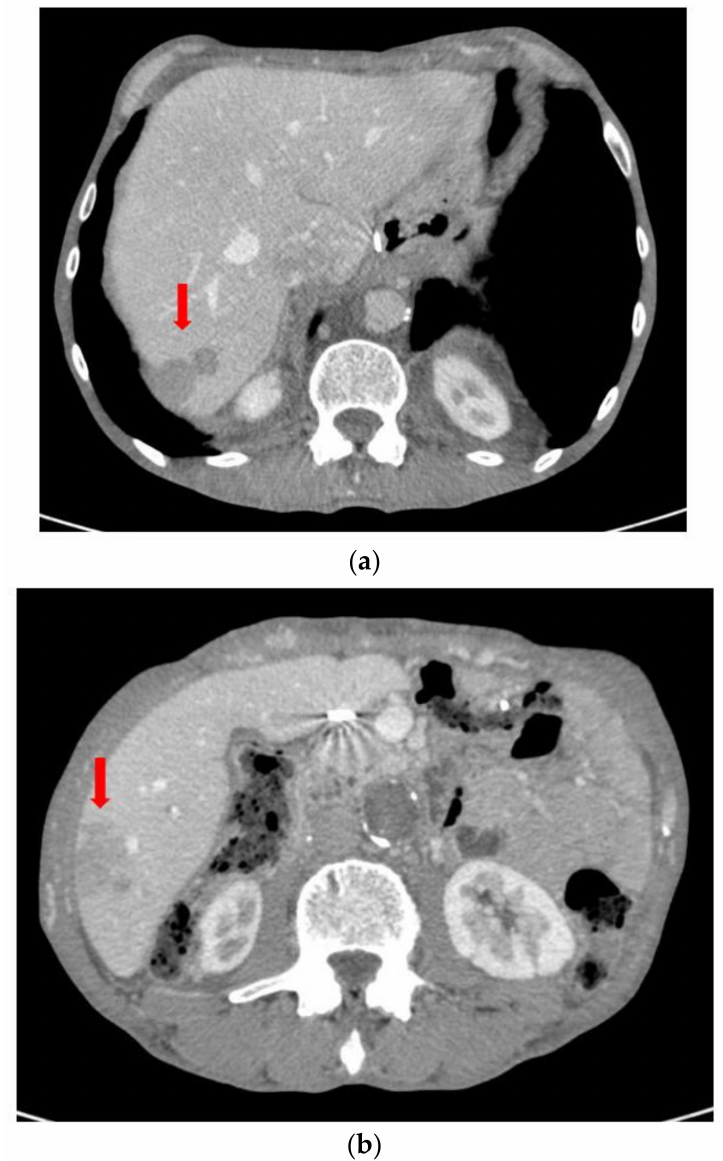
Figure 11. ( a ) Follow-up CT scan after 5 months with evidence of hepatic metastases in S7. ( b ) Follow- up CT scan after 5 months with evidence of hepatic metastases in